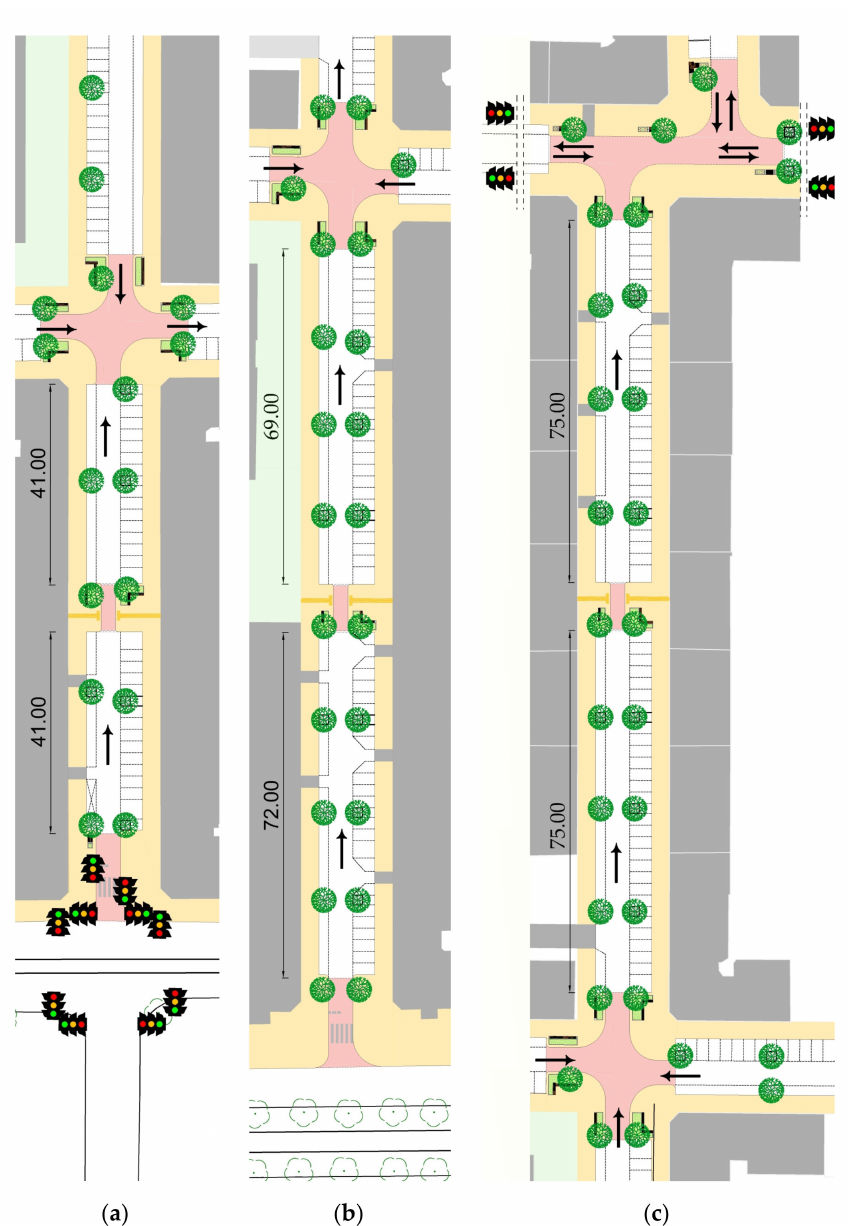
Figure 3. Analysed testing grounds: ( a ) testing ground No. 1; ( b ) testing ground No. 2; ( c ) testing ground No. 3. Arrows show the directions of traffic during the surveys. Source: own work of the author based on [40].